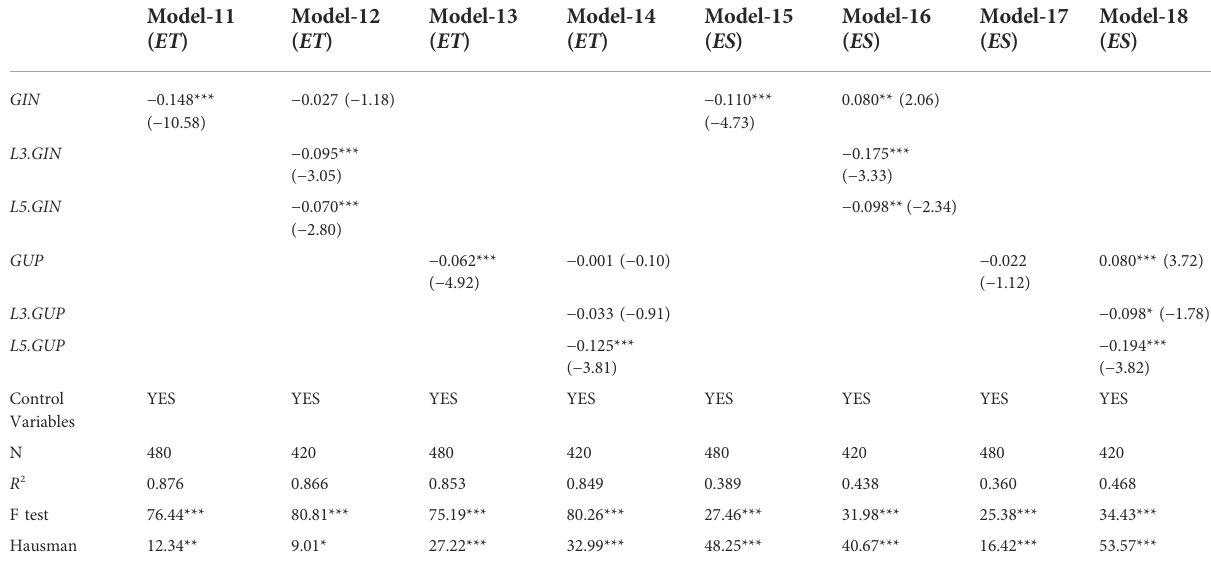
TABLE 4 Empirical results of GIN and GUP on ET and ES .